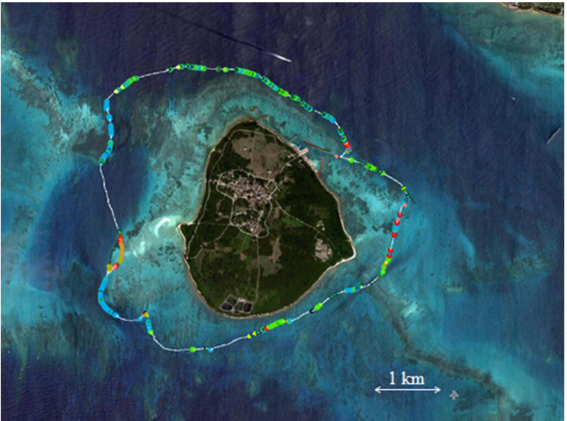
Figure 8. Coral distribution observed by the boat-towed fluorescence imaging LIDAR on 24 January 2015, overlapped with a satellite image (WorldView-3 28 November 2014) of Taketomi Island, Okinawa, Japan. ‚ blue circles: branch-type coral, ‚ green circles: table-type coral, ‚ dark green circles: coral observed at low-resolution, ‚ yellow circles: juvenile coral or coral piece, ‚ red circles: dead coral, ‚ pink circles: dead coral rubble, ‚ light brown circles: sea algae, ‚ dark brown circles: sea